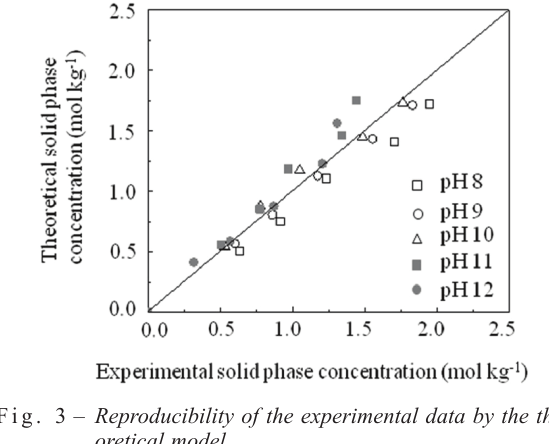
Fig. 3 – Reproducibility of the experimental data by the the- oretical model